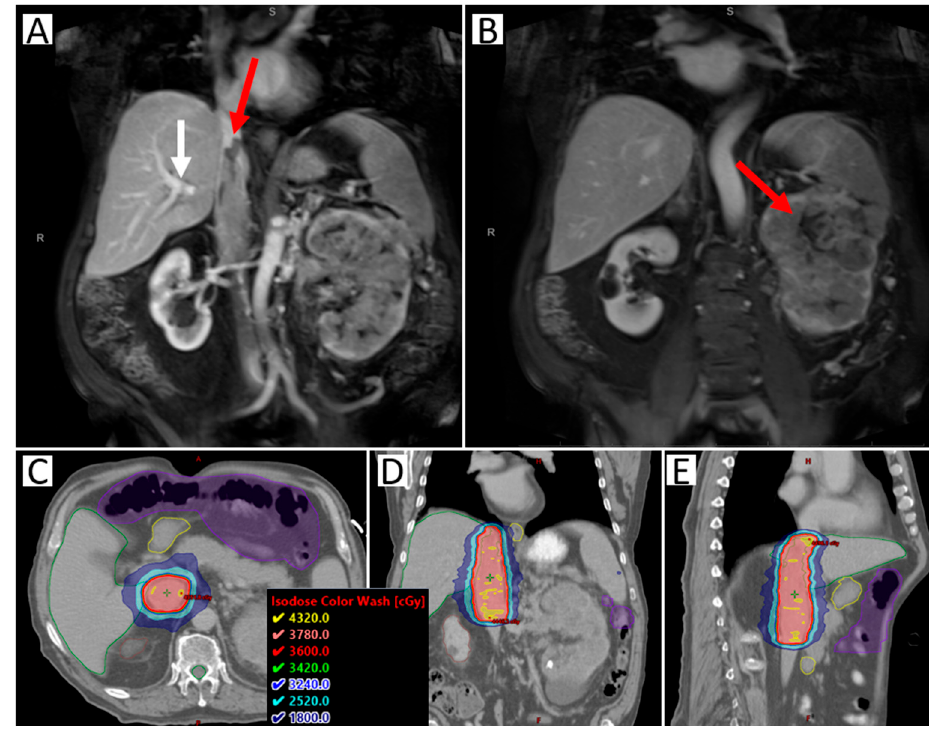
Figure 1. Images of a sample case of a patient with RCC IVC tumor thrombus level III, making resection not possible. The patient was treated with SAbR 36 Gy/3 fractions. ( A ) Coronal abdominal MR with contrast; red arrow highlighting the superior extent of the tumor thrombus; white arrow highlighting tumor thrombus extension beyond the branching of the hepatic artery (blockage the leads to Budd ‐ Chiari Syndrome, making surgery more complicated). ( B ) Coronal abdominal MR with contrast; right arrow highlighting the large left primary kidney tumor. ( C – E ) Axial, coronal, and sagittal CT with radiation dose distribution shown. Nearby organ at risk highlighted include liver (green), duodenum (yellow), bowel space (purple), and spinal cord (green).